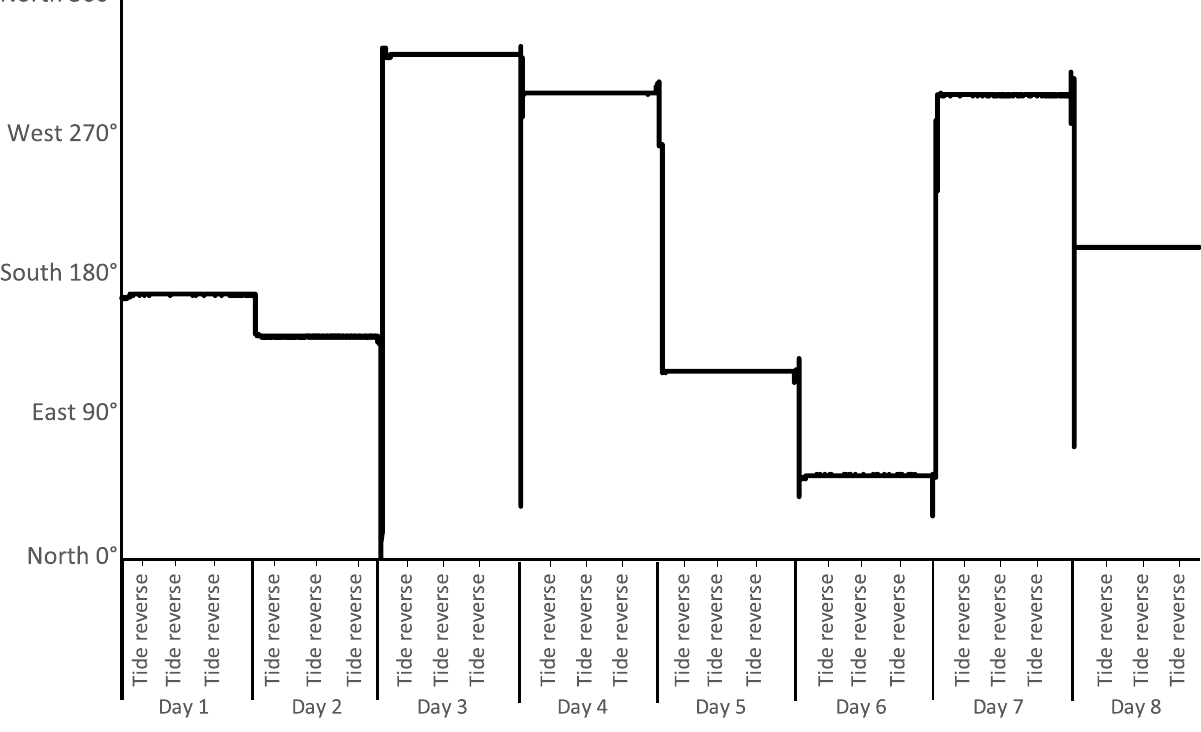
Fig 5. Trap orientation (in degree) during the